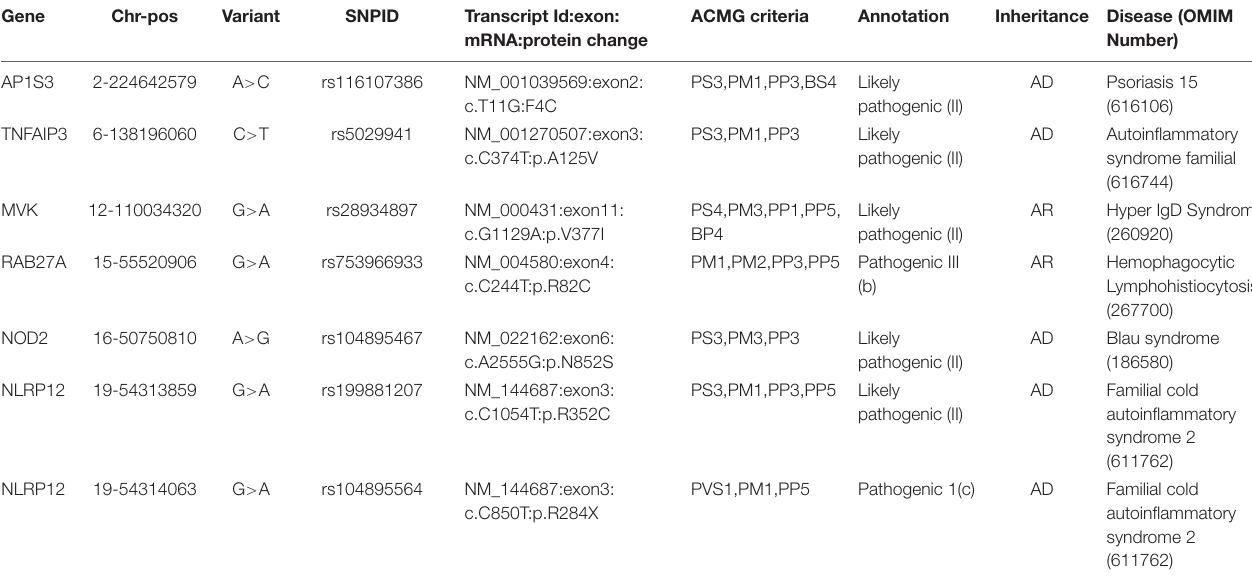
TABLE 1 | Pathogenic and Likely Pathogenic variants annotated as per ACMG guidelines for interpretation of